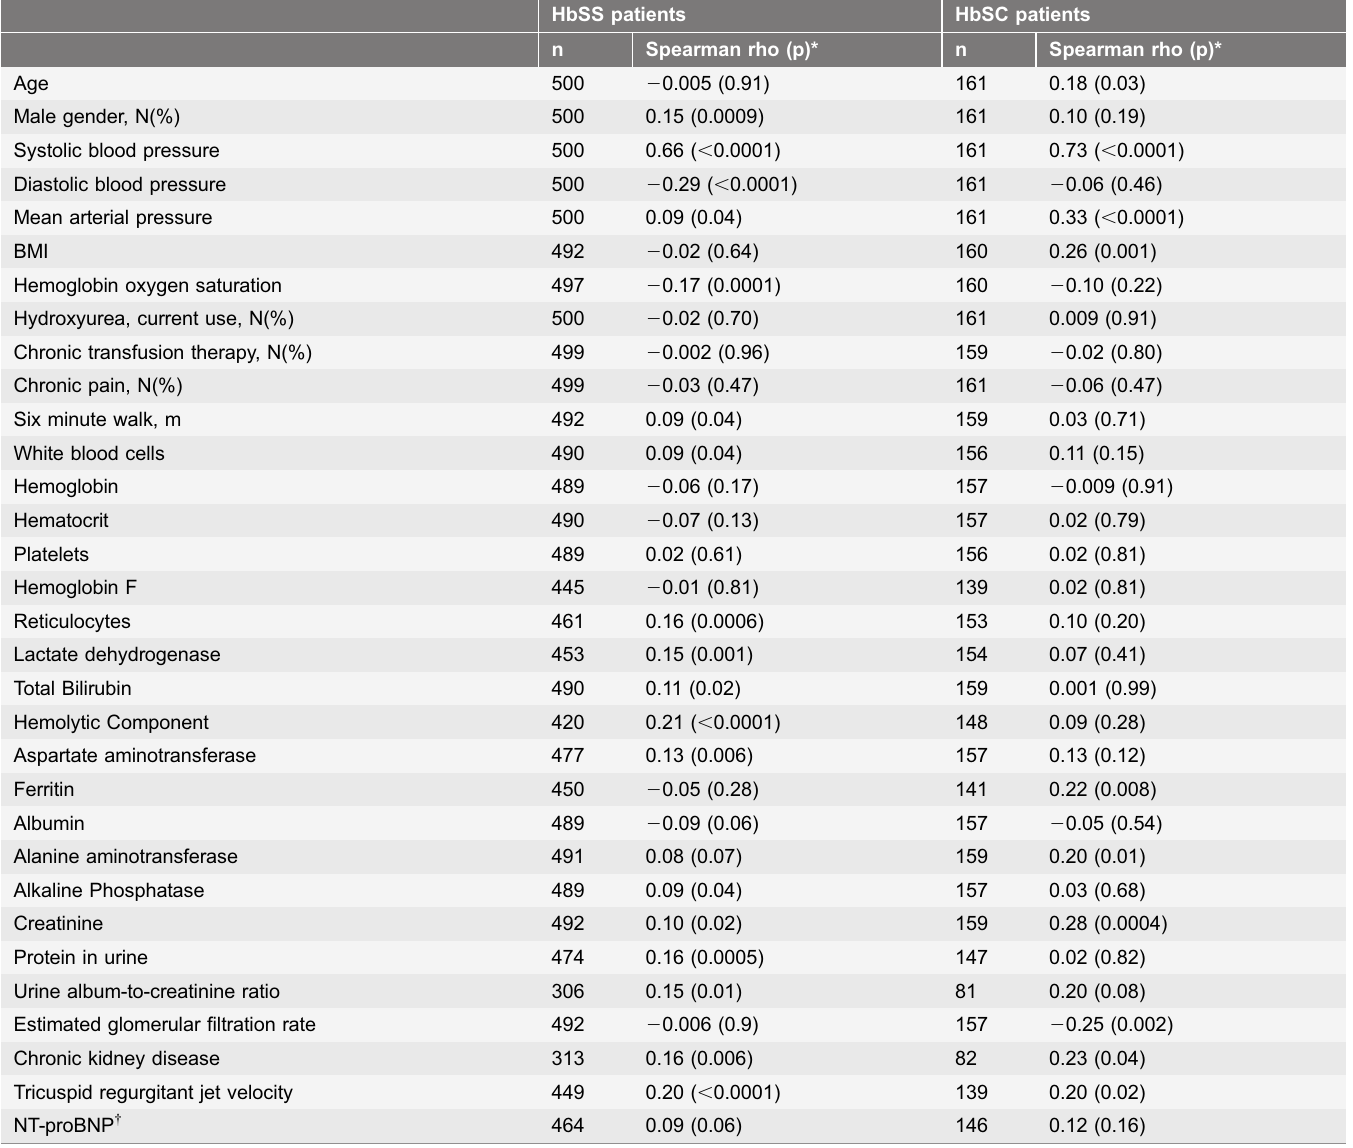
Table 2. Correlations of pulse pressure with clinical and laboratory characteristics by hemoglobin